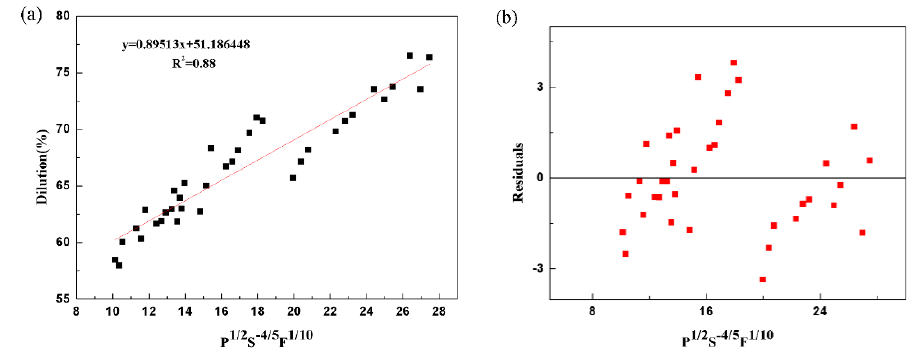
Figure 9. ( a ) The relationship between the dilution rate and the three processing parameters ( P , S , and F ). ( b ) Residuals.